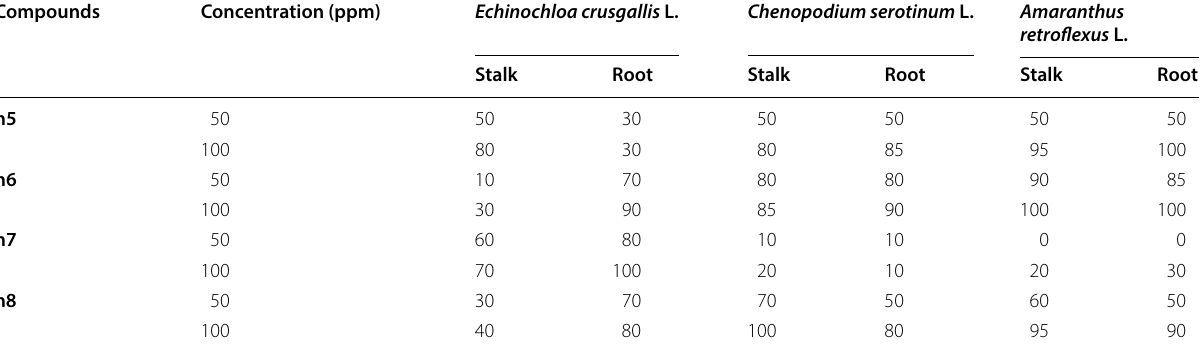
Table 51 The inhibition percentage of the target compounds against various weeds Compounds Concentration (ppm) Echinochloa crusgallis L.